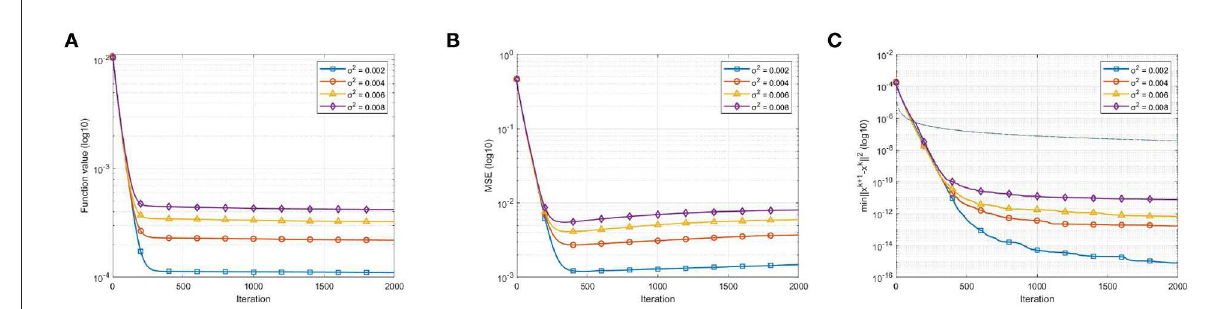
FIGURE2 Convergence behavior in the case of noisy data: (A) Function value vs. number of iterations, demonstrates the sufficient descent and convergent f ( x k ) property of the function value sequence ; (B) MSE vs. number of iterations, demonstrates the convergent property of the point sequence { }